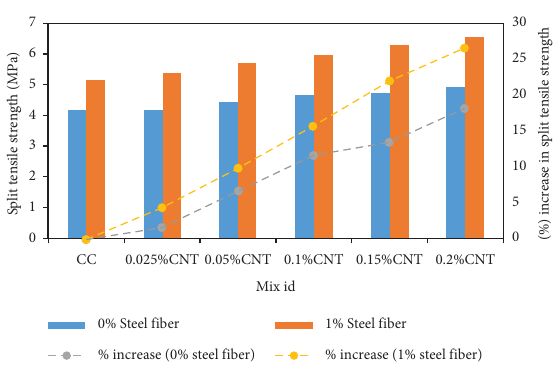
Figure 9: Splitting tensile strength for